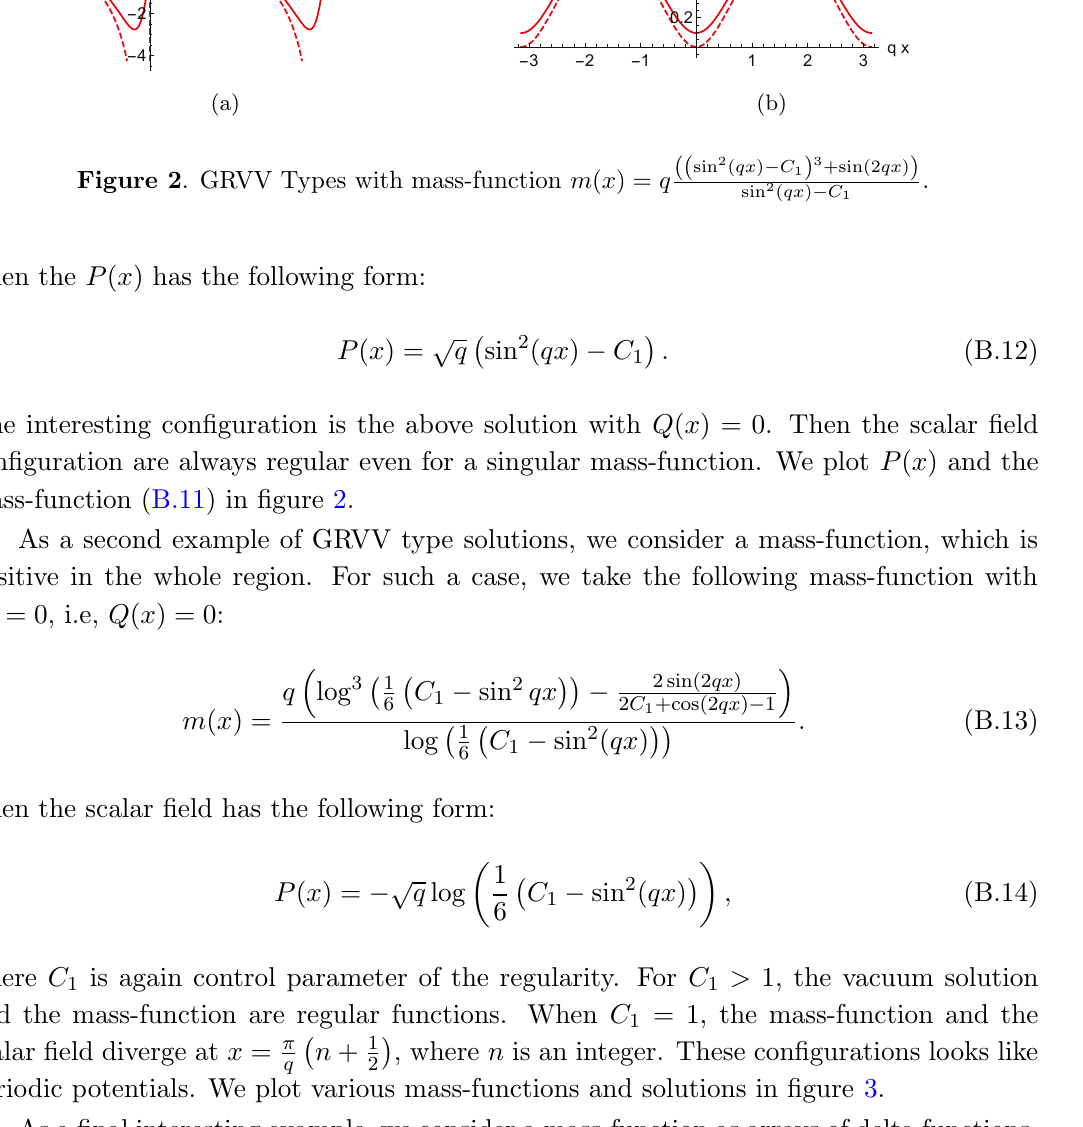
(( sin 2 ( qx ) (cid:0) C ) 3 +sin(2 qx ) ) 1 sin 2 ( qx ) (cid:0) C 1